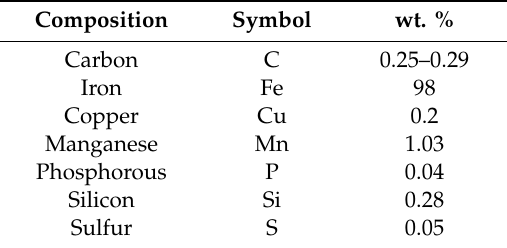
Table 1. ASTM A36 composition